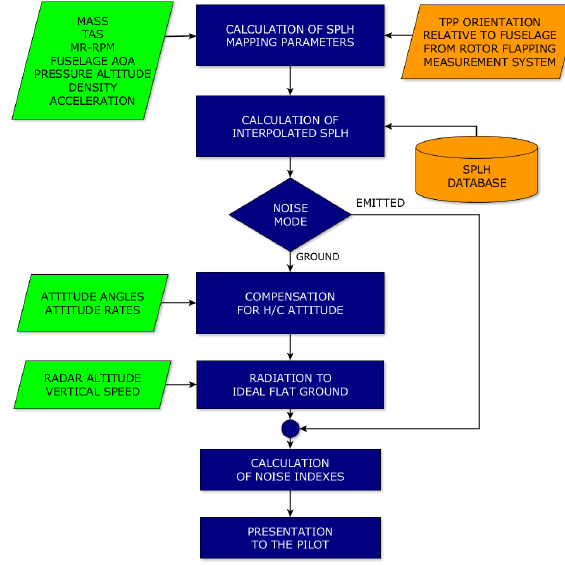
Figure 28: Flow chart of the noise estimation computational proce-